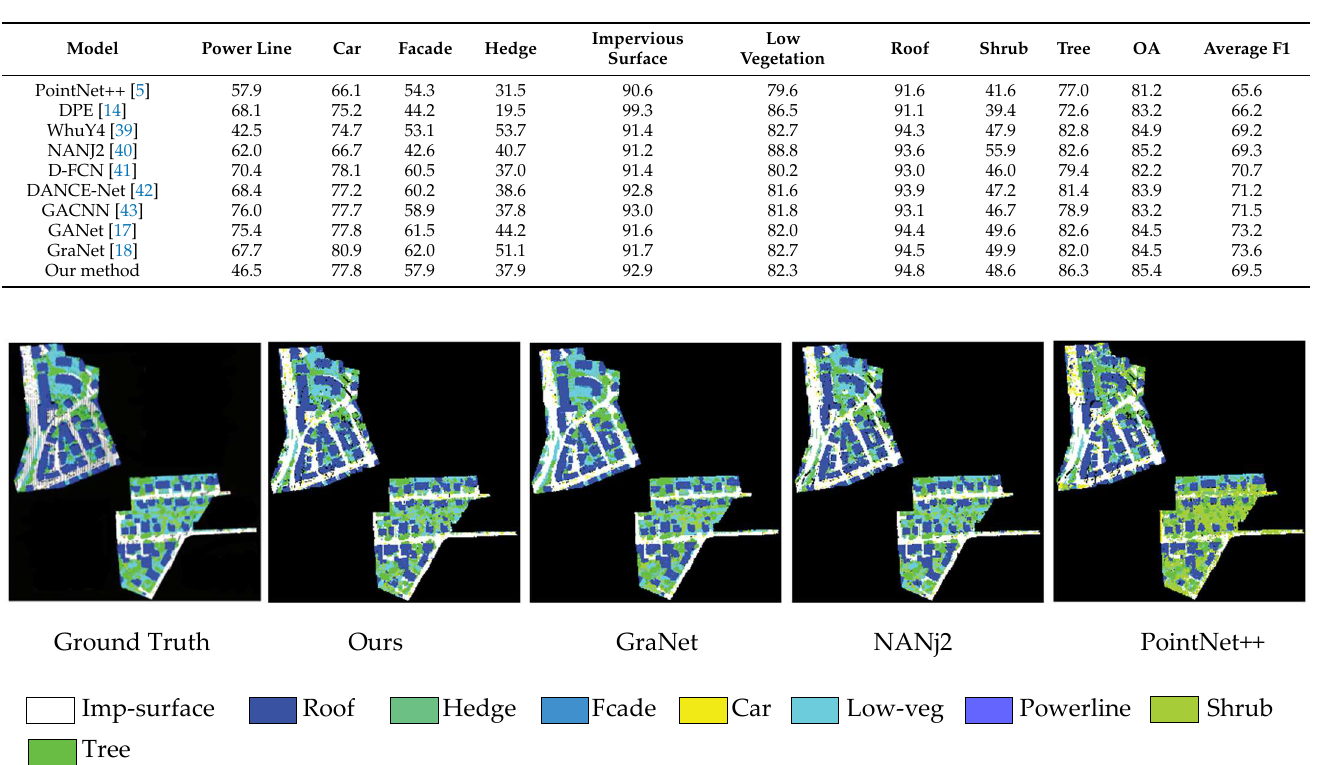
Table 7. Comparison of F1 score and OA of different methods (%).